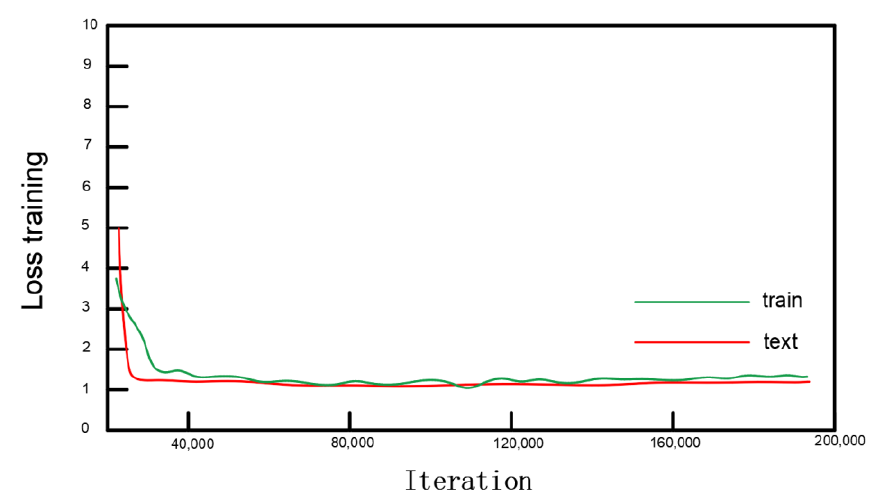
Figure 8 . Loss of the Faster R-CNN model incorporating FPN. Figure 8. Loss of the Faster R-CNN model incorporating FPN.